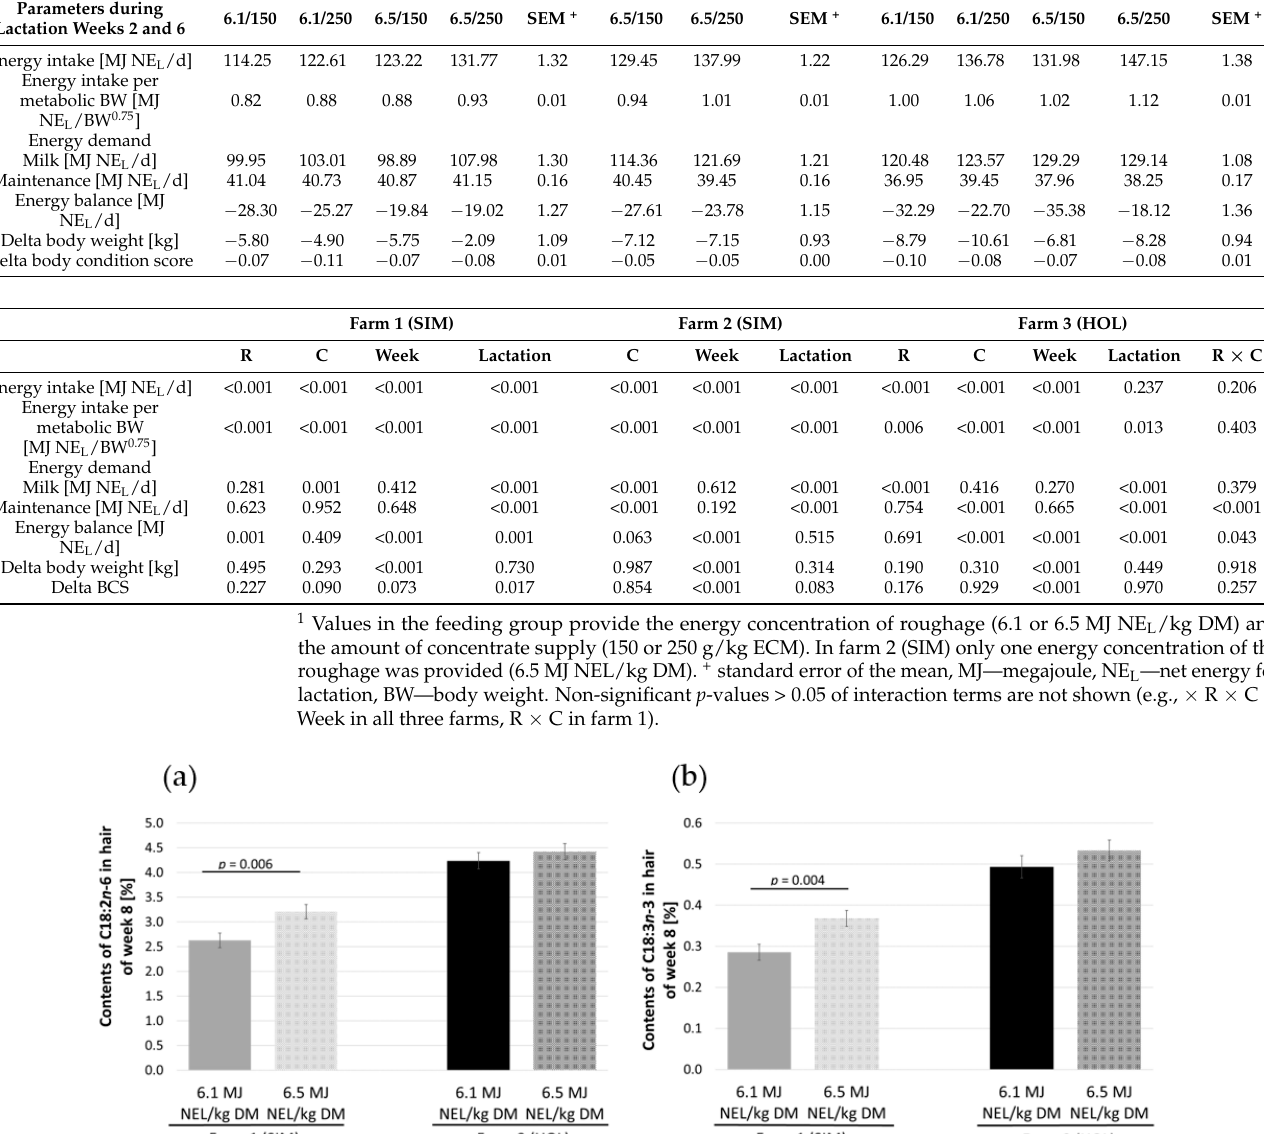
Table 2. Feeding group-specific effects within each farm on parameters of energy availability during lactation weeks 2 and 6. In the upper part, LS-means of the parameters per feeding group are shown; in the lower part, p -values are provided for the effects of the energy concentration of the roughage (R), the concentrate supply (C), the lactation number (Lactation), and the interaction between the energy concentration of the roughage and the amount of concentrate supply (R × C if any interaction is significant). Farm 1 (SIM) Farm 2 (SIM) Farm 3 (HOL) Feeding Group 1